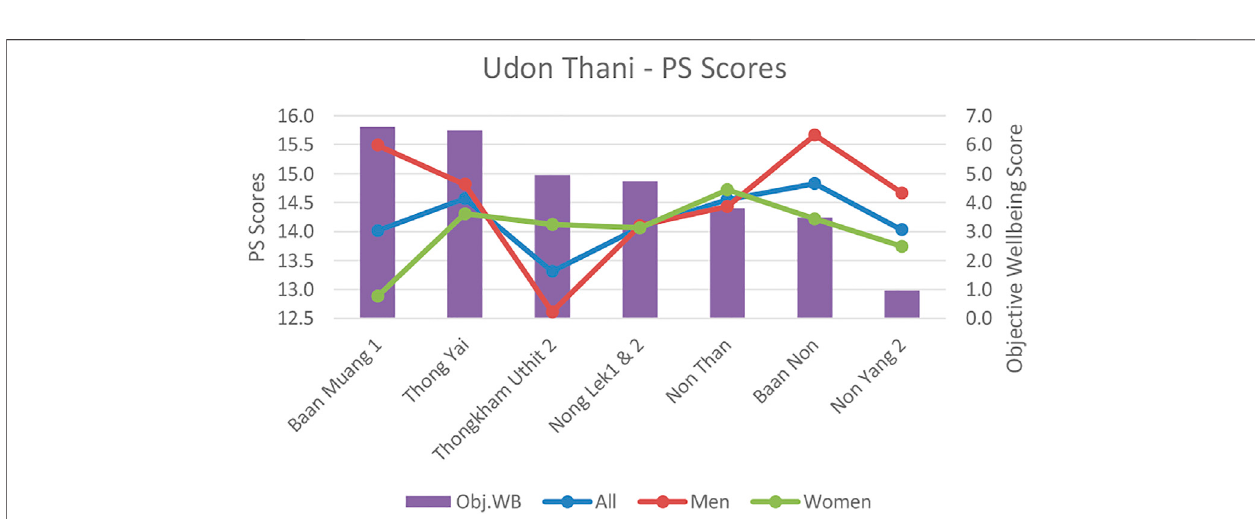
FIGURE 6 | Udon Thani perceived stress scores versus objective wellbeing scores by neighbourhood.